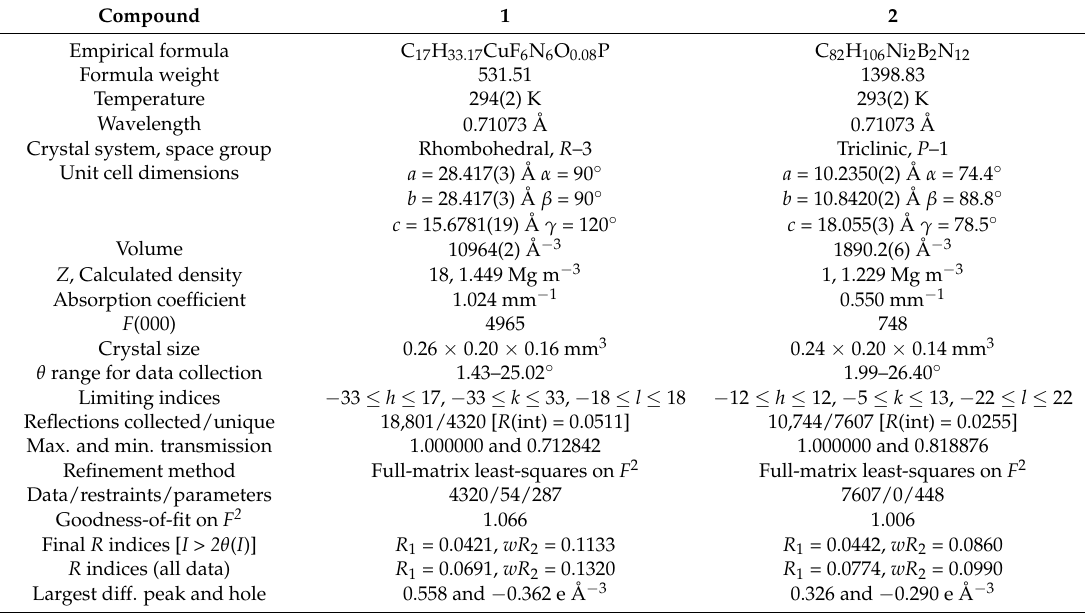
Table 1. Crystal data and structure refinement for 1 and 2 .